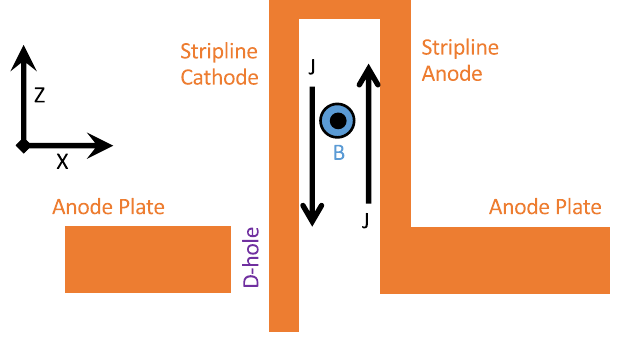
striplines.FIG. 1. Illustration of stripline load geometry. The stripline is mounted directly to the Z machine top plate on the anode side, while the cathode stalk passes through a D-shaped hole (the flat side of the hole is flush with the anode stalk) in order to connect to the upper cathode (not shown). The D-hole geometry allows for a break from the standard cylindrical power flow geometry of the Z